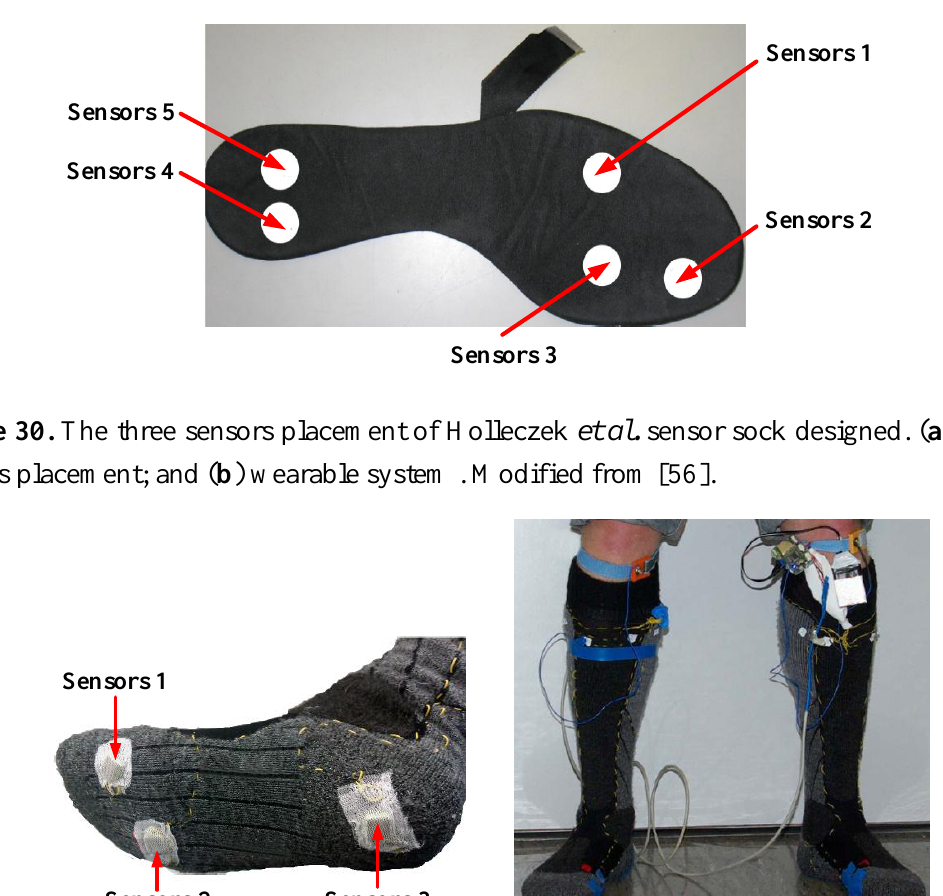
Figure 29. The five sensors placement of Salpavaara et al. designed system. Modified from [55].